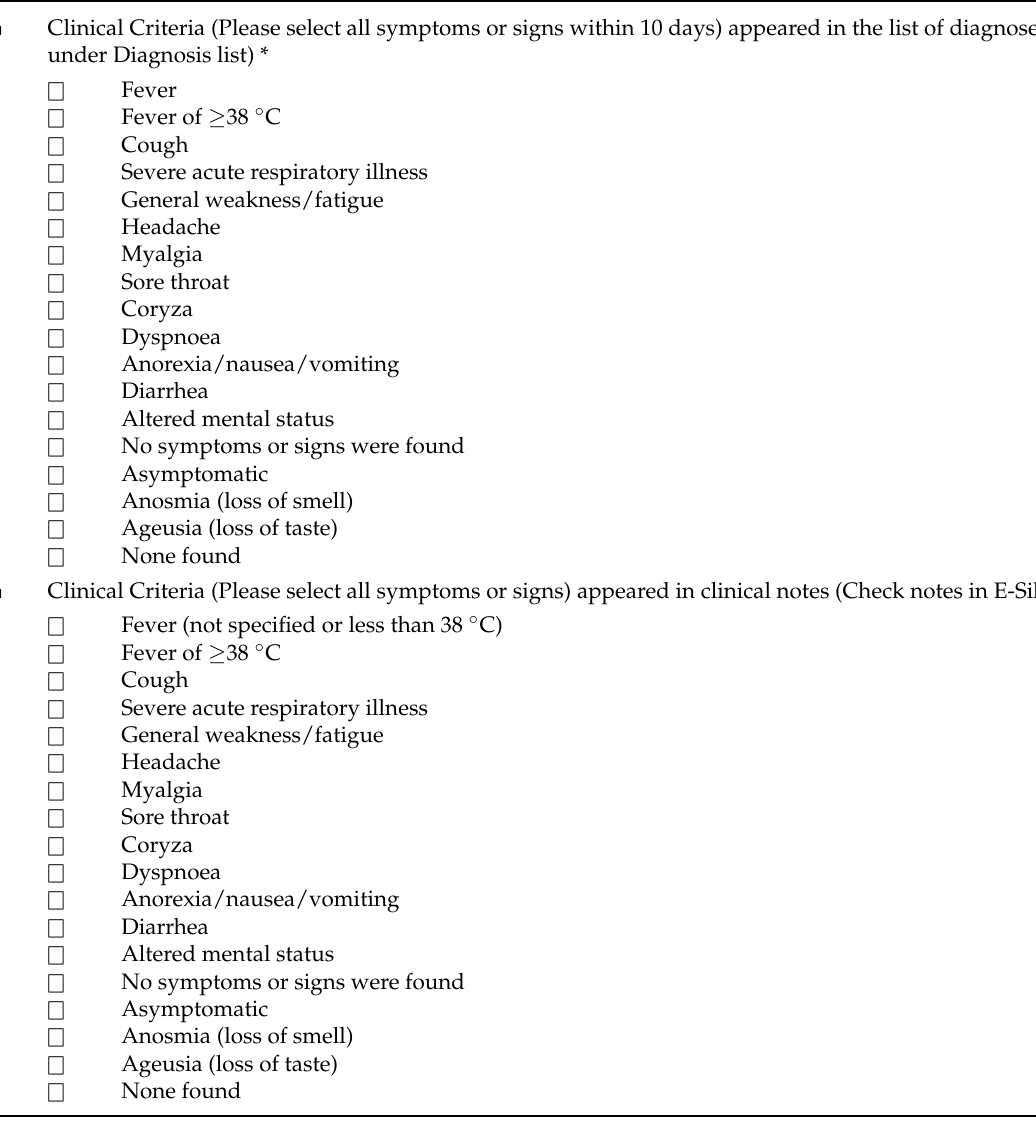
Table A1. The Structured Form Was Used for Chart